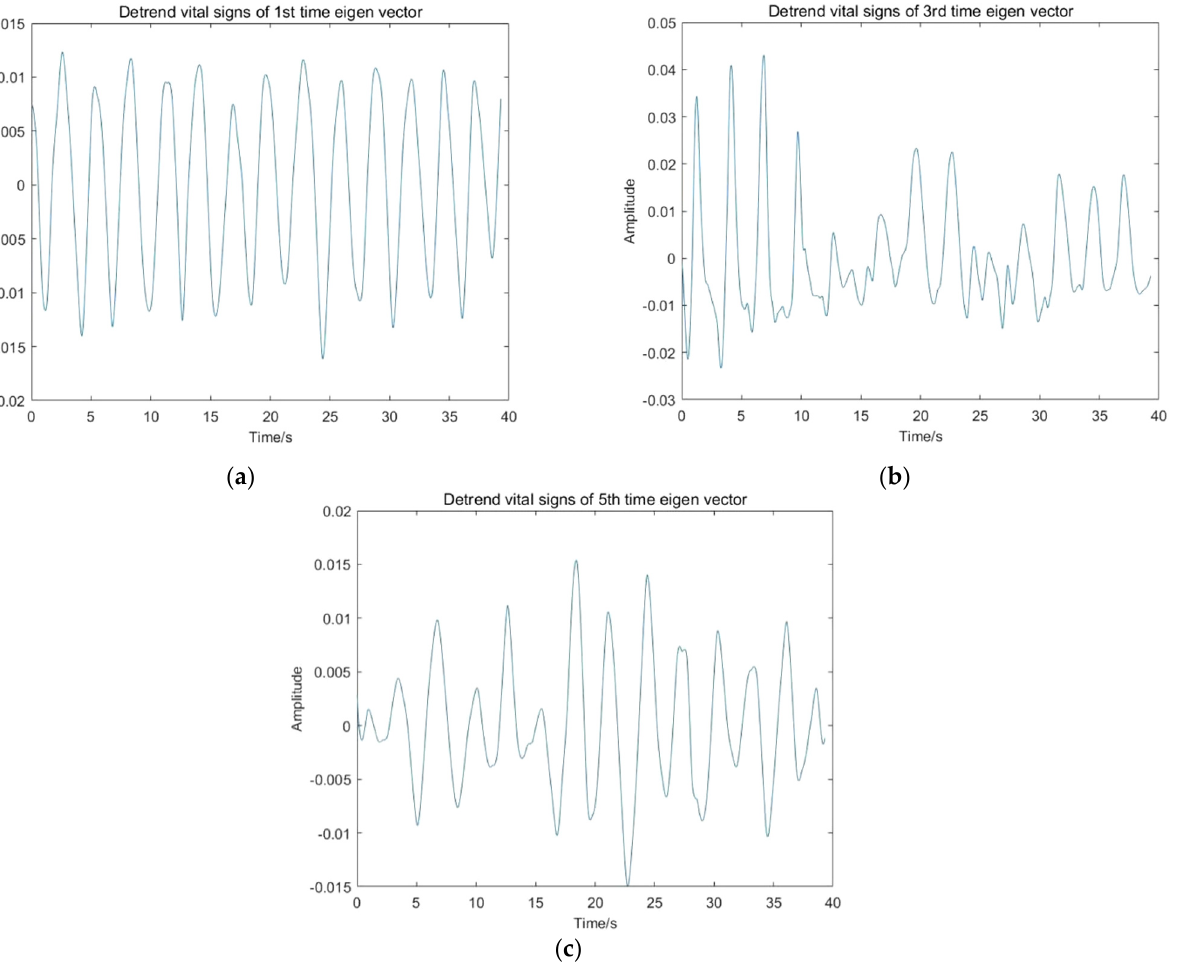
Figure 17. Linear trend suppression effects of vital signs: ( a ) Detrend vital signs of first temporal eigenvector; ( b ) Detrend vital signs of third temporal eigenvector; ( c ) Detrend vital signs of fifth temporal eigenvector.